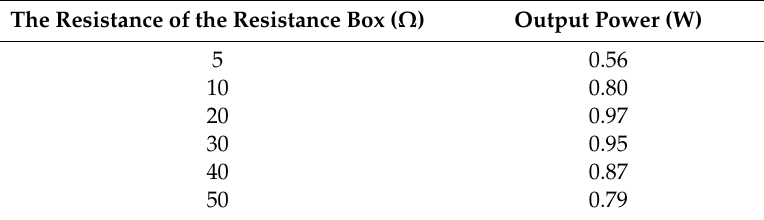
Table 3. Output power with different resistances.